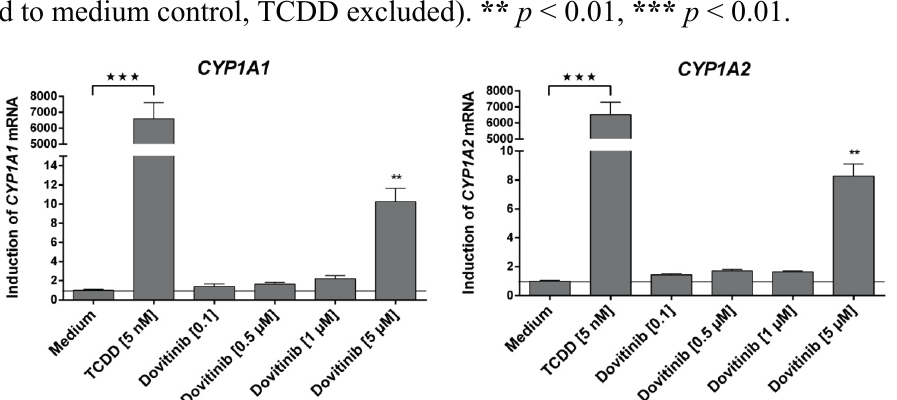
Figure 3. Induction assay. Concentration-dependent effect of dovitinib (0.1–5 µM) and 5 nM TCDD after four days on mRNA expression in LS180 cells. Expression data were normalised to the housekeeping gene G6PDH . Data are expressed as mean ± SEM for n = 18 (four biological replicates and two PCR runs for every sample) and normalised to medium control (set to 1). Statistical significance was tested with student’s two-tailed t -test for TCDD compared to medium control and with ANOVA with Dunnett’s post hoc test (for dovitinib compared to medium control, TCDD excluded). ** p < 0.01, *** p <